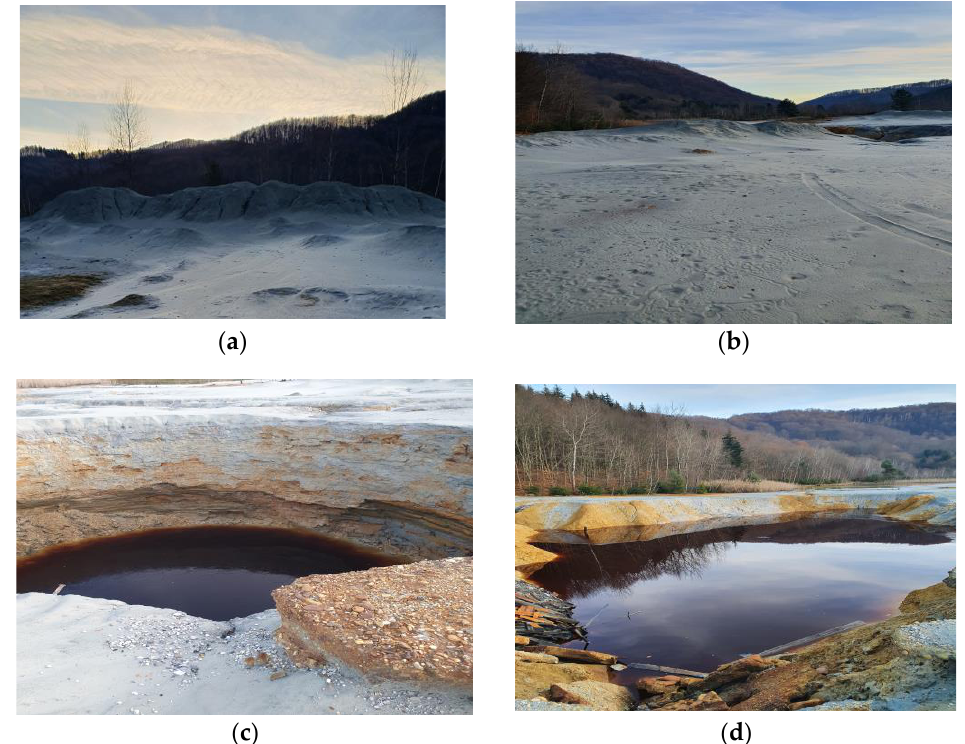
Figure 3. Mixed ore concentrate on the corroded platform of Bloaja sterile dump, Băiuț area, Maramures county, Romania (photos: I.A.P.): ( a ) Piles of ore concentrate; ( b ) Mining concentrate dispersed by atmospheric agents on the surface of the sterile dump; ( c ) Huge circular hole on the surface of the sterile dump caused by mining concentrate; ( d ) Huge and wide hole on the surface of the sterile dump filled with acid water.